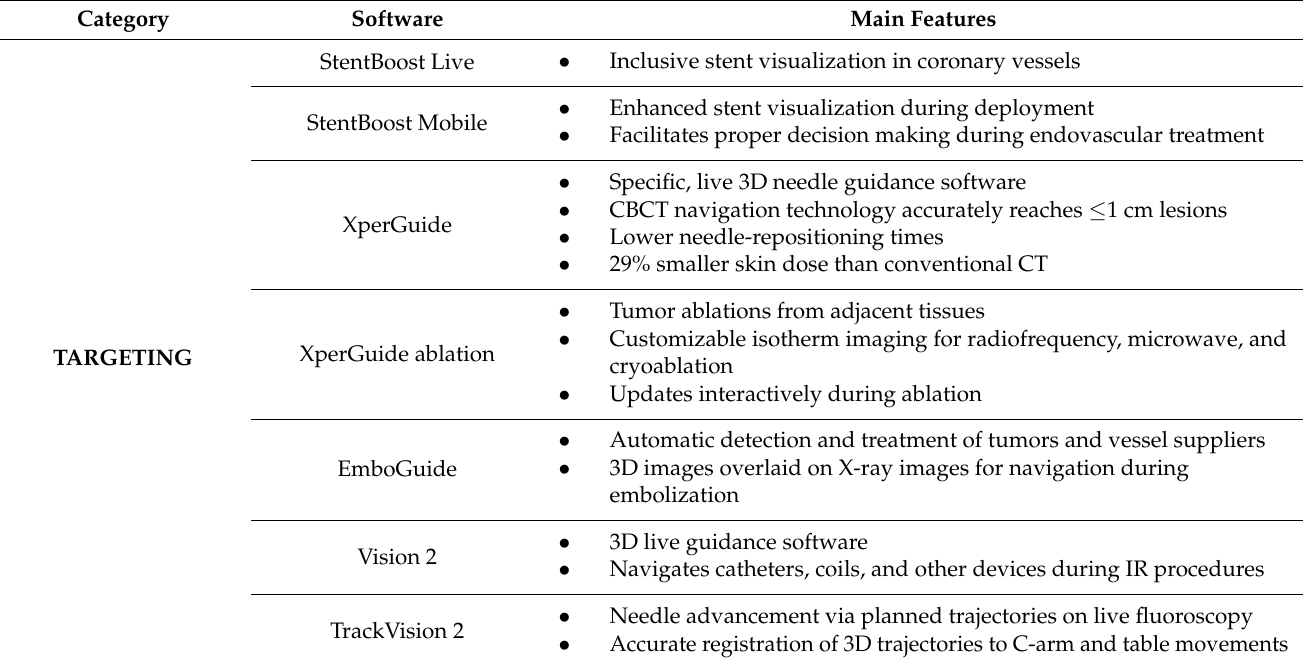
Table 2. Summary of commonly available (TARGETING) procedural software used in interventional